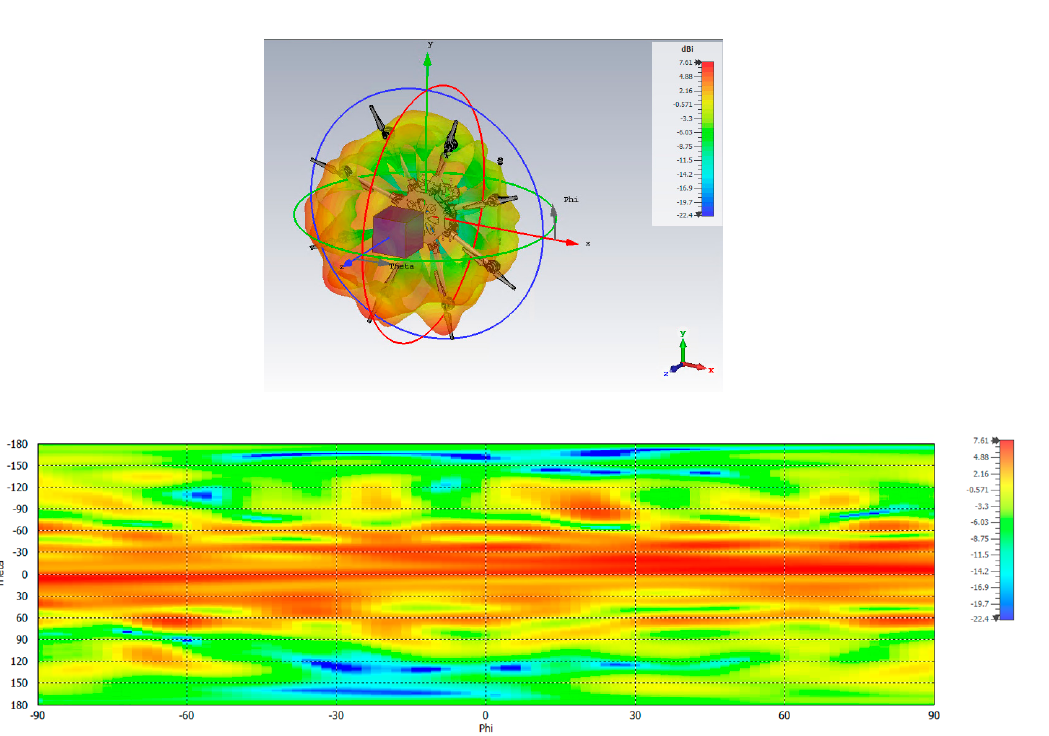
Figure 18. RHCP radiation pattern of the DLR antenna array in Mode 1 once mounted on a drone: ( top ) 3D view; ( bottom ) 2D view.